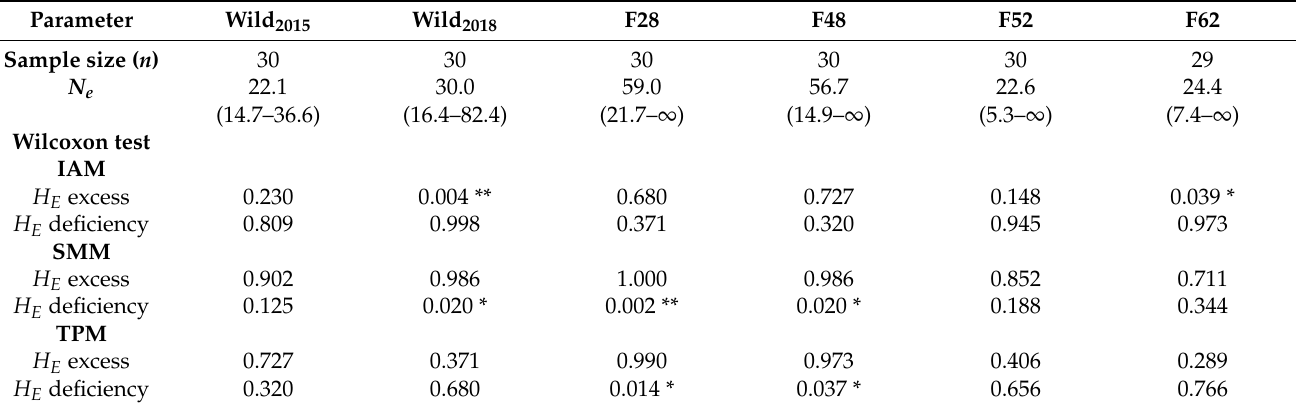
Table 1. Wilcoxon signed rank test p -values for heterozygote excess and deficiency under the infinite alleles model (IAM), stepwise mutation model (SMM) and two-phase model (TPM), as well as estimates of effective population size ( N e ) calculated using the linkage disequilibrium method. 95% confidence intervals are given in